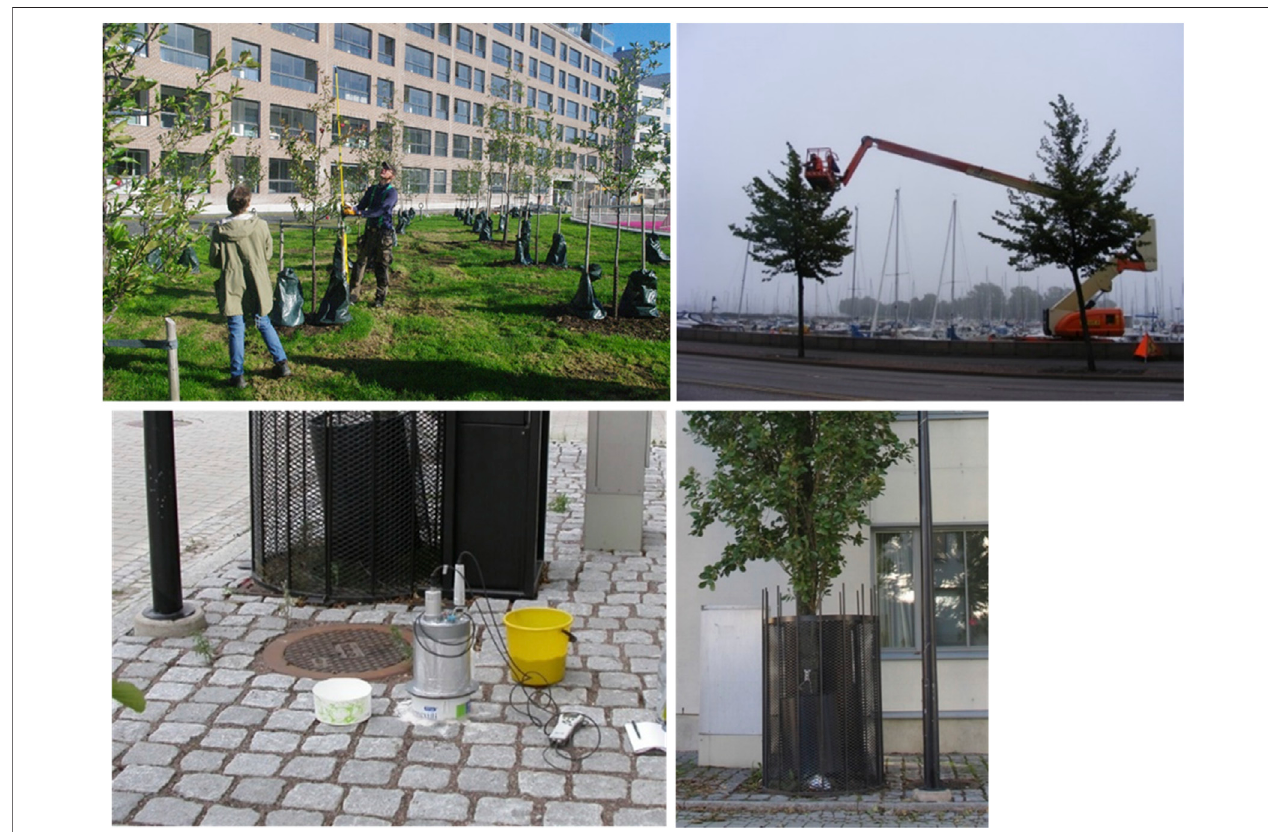
FIGURE 1 | (A – D) clockwise]. Measurements of tree dimension from young trees in Hyväntoivonpuisto (A) and demonstration of how complicated can the collection of leaf biomass samples from street trees higher than 2 – 3 m be (B) . Portable chamber system with infrared carbon dioxide analyzer and temperature